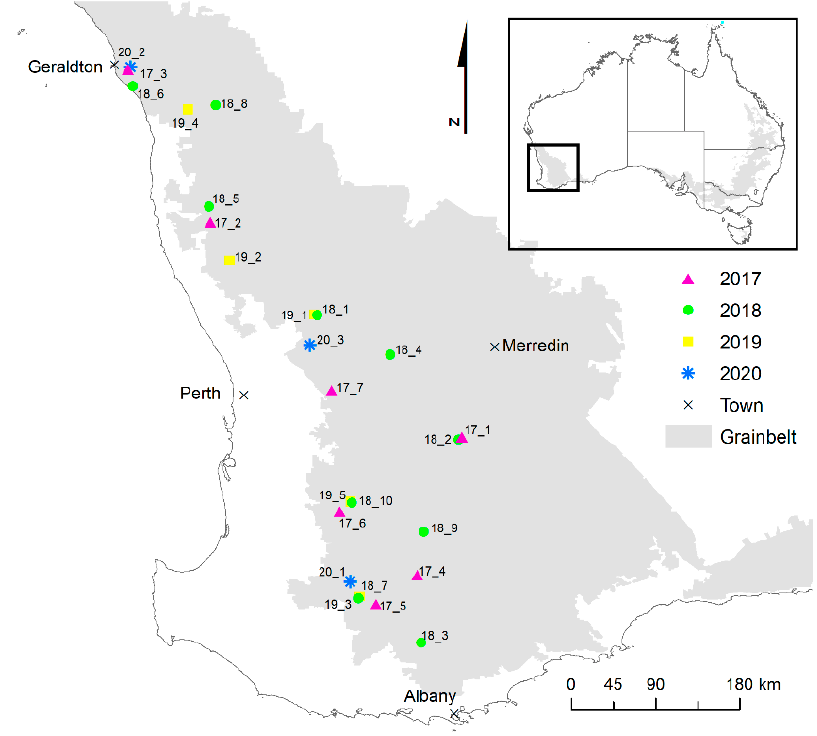
Figure 1. Map showing locations of Sclerotinia stem rot field trials established within the south- western Australian grain belt in 2017 (7 sites), 2018 (10 sites), 2019 (5 sites) and 2020 (3 sites). Table 1. Description of canola varieties sown per year.